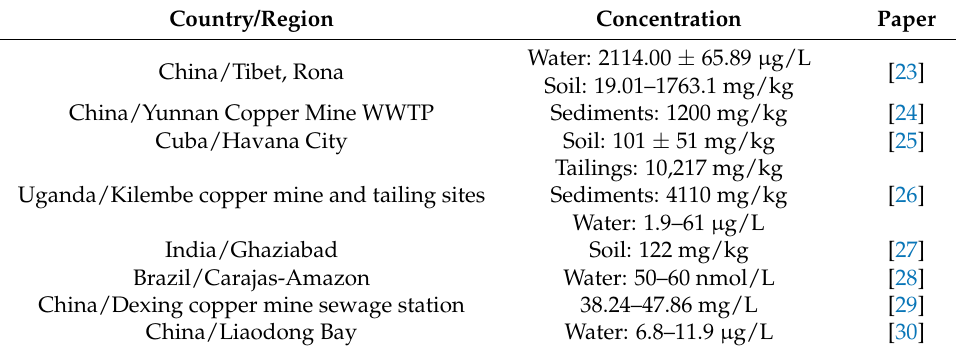
Table 1. Cu concentrations around the